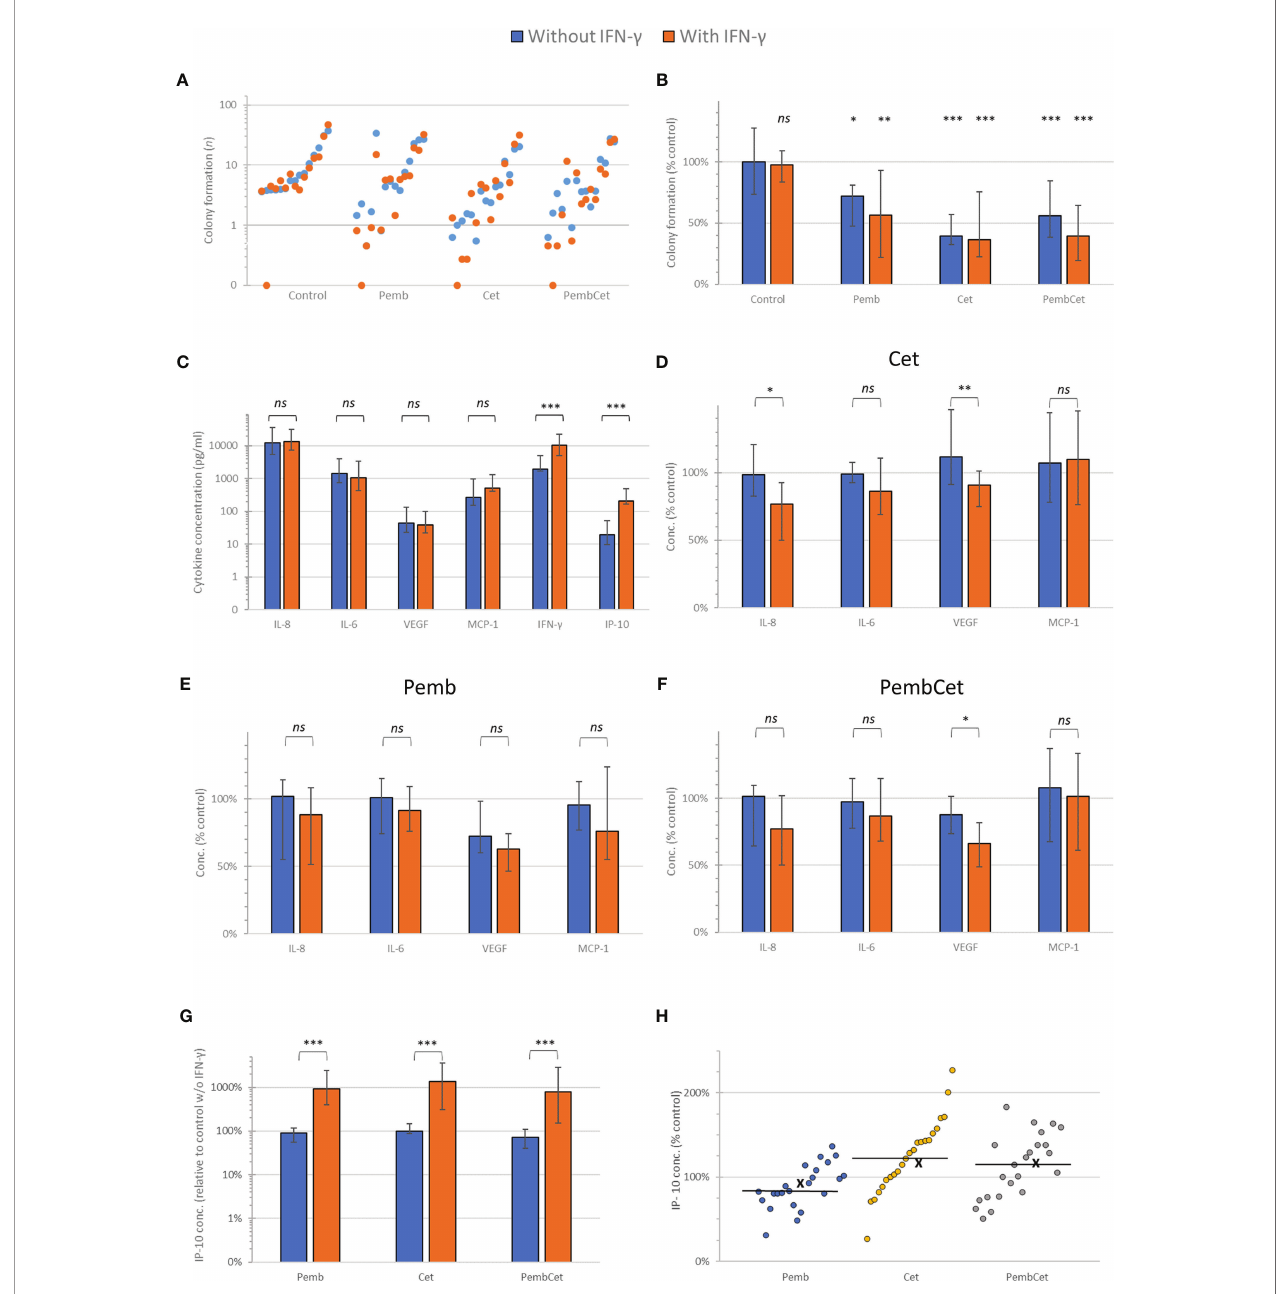
FIGURE 1 | Ef fi cacy of pembrolizumab ( Pemb ), cetuximab ( Cet ), and the combination of both antibodies ( PembCet ) without ( blue ) or with interferon-gamma (IFN- g ) in the FLAVINO assay. (A) Dot plot representing the mean number of epithelial cell colonies formed (CFec) by the individual head and neck squamous cell carcinoma (HNSCC) samples sorted in ascending order of CFec in 12 control replicates without IFN- g and accompanied by the corresponding mean CFec under IFN- g treatment. (B) Median and interquartile range of CFec normalized to the untreated control (100%) by Pemb, Cet, and PembCet without or with 10 ng/ml IFN- g showing the huge heterogeneity of HNSCC in response to treatments. (C) Mean and 95% CI of the cytokine concentrations in supernatants of untreated controls and after IFN- g stimulation at 72 h (D – F) Cytokine concentrations normalized to the untreated control without and with IFN- g stimulation at 72-h treatment with cetuximab (D) , pembrolizumab (E) , and PembCet (F) . (G) Effect of treatment indicated on interferon gamma-induced protein 10 (IP-10) production normalized to the control without IFN- g (please note logarithmic scaling). (H) Dot plot showing the IP-10 concentrations observed for individual HNSCC samples as percentage of individual IFN- g -treated control ( x , mean; horizontal line , median). *p < 0.05; **p < 0.005; *** p < 0.001; ns , not signi fi